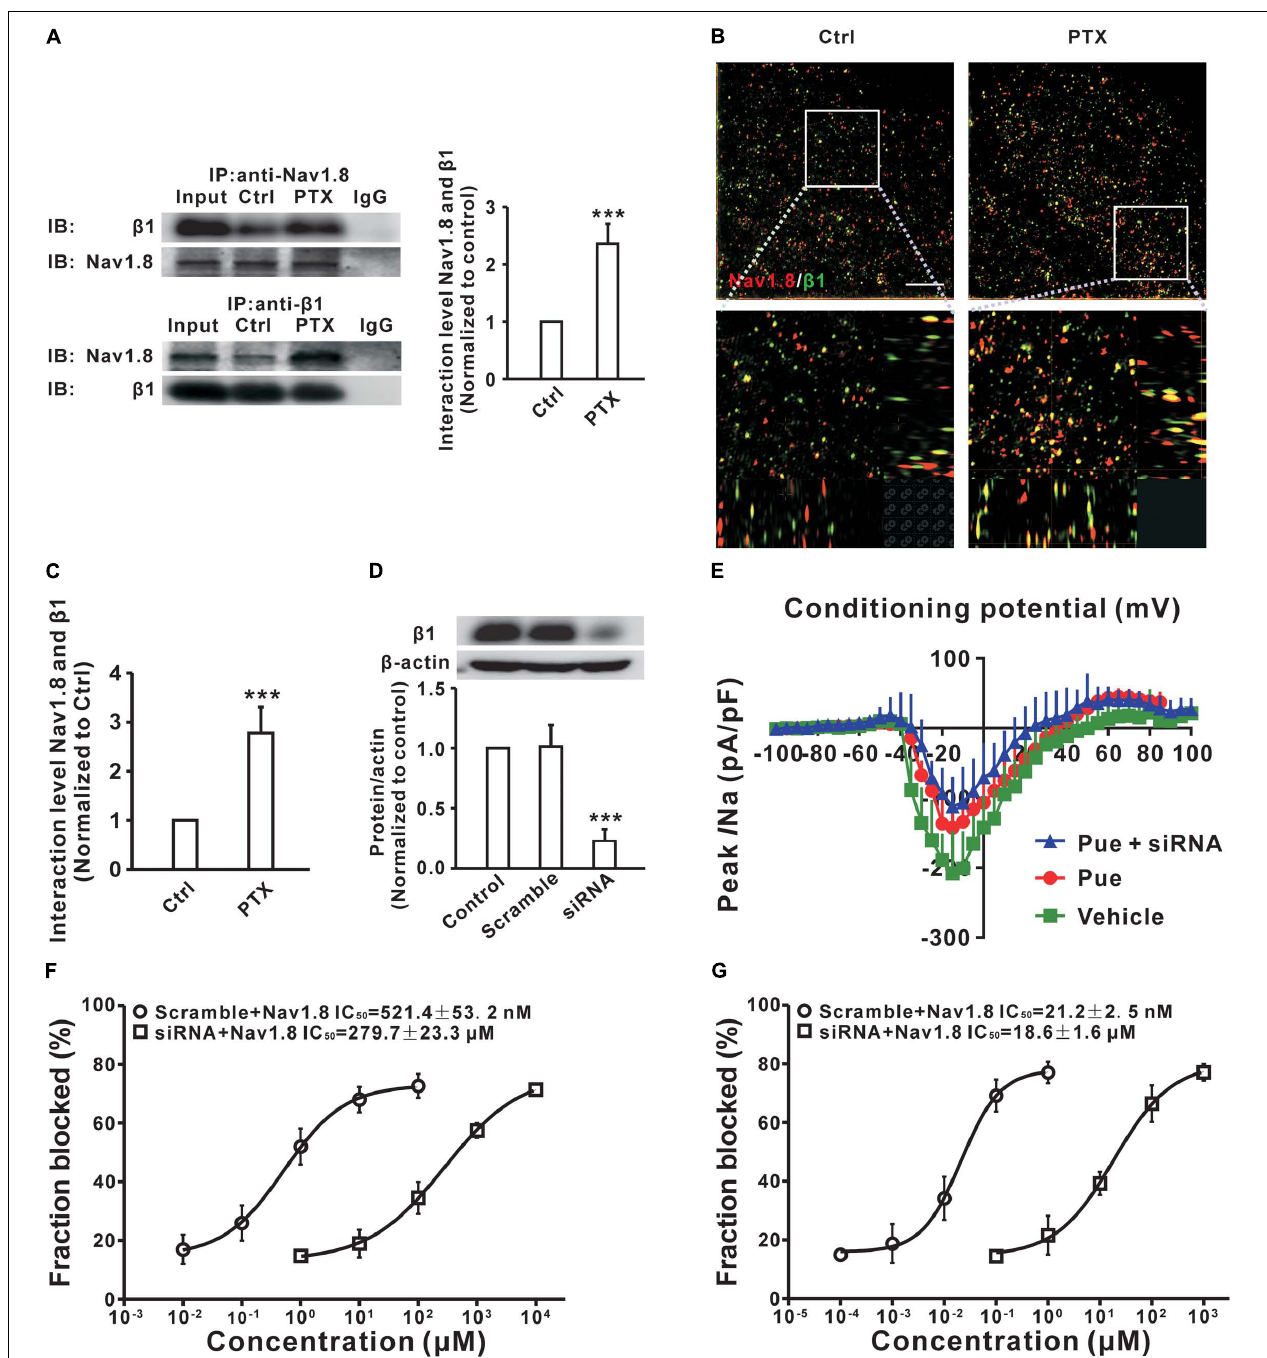
FIGURE 8 | Puerarin inhibits Na v 1.8 in a neuropathic pain state may by blocking β 1 subunit in DRG neurons (Ctrl, control; PTX, paclitaxel; Pue, puerarin). (A) Co-IP showed that paclitaxel treatment significantly increased the binding between Na v 1.8 and β 1. n = 6 rats in each group. ∗∗∗ P < 0.001 compared with control group. (B,C) High resolution image showed that the colocalization between Na v 1.8 and β 1 subunit in DRG neuron. n = 4 rats. ∗∗∗ P < 0.001 compared with control group. Scale bars: 5 µ m (top) and 1 µ m (bottom). (D) siRNA knock down the protein expression of β 1 subunit in DRG. n = 6 rats in each group. ∗∗∗ P < 0.001 compared with scramble group. (E) Representative voltage-clamp recordings of Nav1.7 current in acute dissociated DRG neurons of day 10 paclitaxel-treated rats collected using a subtraction protocol (the current obtained following subtraction of the residual current following ProTx II administration from the total) the mean current density–voltage relationships are plotted in (D) . n = 10 neurons in each group. (F,G) The IC 50 of puerarin on resting (F) or inactivated (G) state for Na v 1.8 in β 1 subunit knock down and scramble DRG neurons of paclitaxel (day 10) rats. n = 10 neurons in each data point.